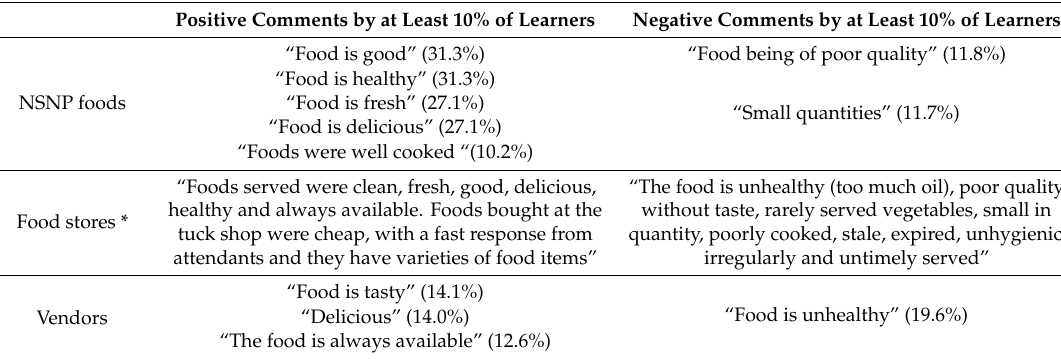
Table 5. Learners’ views on foods provided by the National School Nutrition Program (NSNP) and those sold in the school stores and by